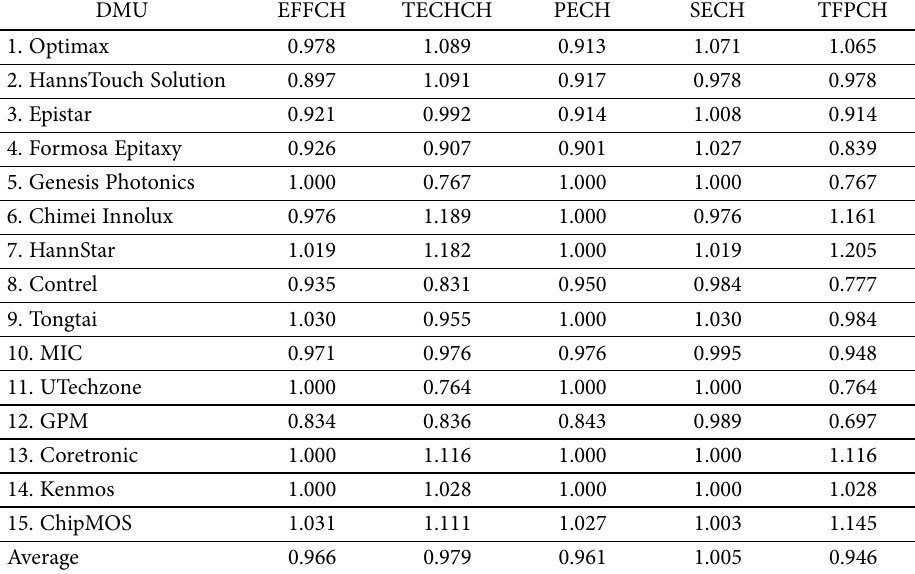
Table 10. 2007–2011 Efficiency score